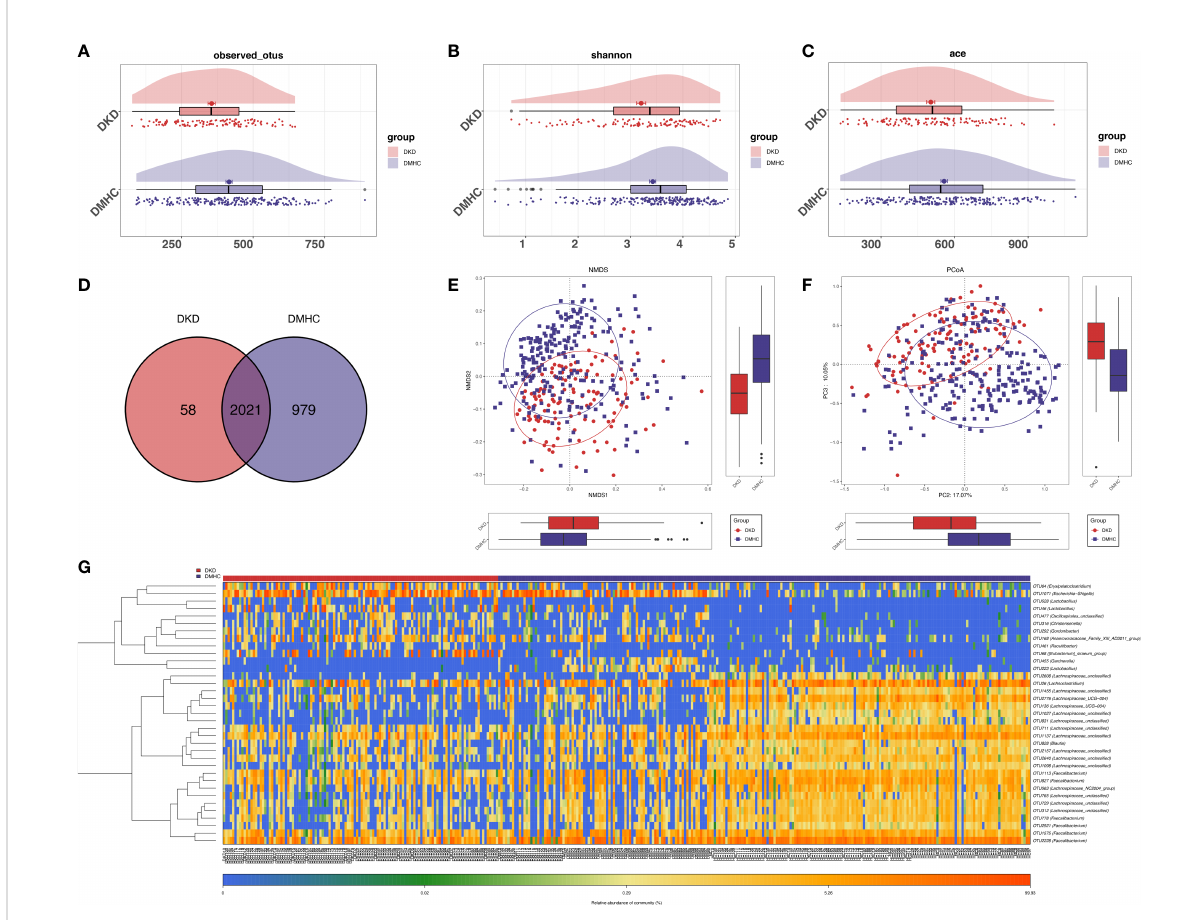
FIGURE 2 Bacterial diversity in discovery cohort (DKD = 120, DM = 140, and Con = 92). a diversity: Bacterial richness and diversity of DKD and non-DKD group comparison were assessed by observed OTUs (A) and Shannon/Ace indices (B, C) , respectively. Venn diagram (D) showed that observed OTUs among two groups. b diversity: NMDS analysis (E) based on unweighted UniFrac distance (ANOSIM, R 2 = 0.1123, p = 0.0001). PCoA analysis (F) was measured by unweighted UniFrac distance at the OUT level. Adonis revealed that unweighted analysis taking OTU abundance into account could better re fl ect the spatial differences among two groups ( R 2 = 0.0247, p = 0.001). (G) Distribution of key OTUs between DKDs and non-DKDs. Through Wilcoxon rank-sum test, a total of 35 OTUs with p -value > 0.05 and abundance > 0.03% were considered as key lineages for DKD. Blue color represented lower abundance. Orange color represented higher abundance. PCoA, principal coordinate analysis; PC, principal component, PC1, PC2, and PC3. NMDS, non-metric multidimensional scaling analysis; Adonis, permutational/nonparametric multivariate analysis of variance; ANOSIM, analysis of